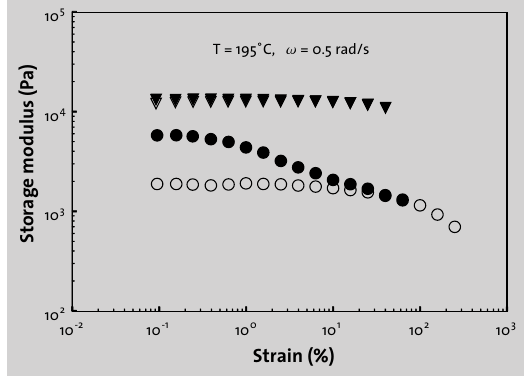
Figure 5 (left above): Changes in storage modulus with repeated strain sweeps for composites reinforced with 13% of talc 1 and based on different polyethylenes (first sweep: Ê LLDPE, Ù LDPE; second sweep: Á LLDPE, ı LDPE). Fig. 6a (right above): Changes in storage modulus with repeated frequency sweeps for 22% talc1/LLDPE composite (first sweep: Ï composite; Ï LLDPE; second sweep: Ì composite). Fig. 6b (right below): Changes in complex viscosi- ty with repeated frequency sweeps for 22% talc1/LLDPE composite (first sweep: Ï composite; Ï LLDPE; second sweep: Ì